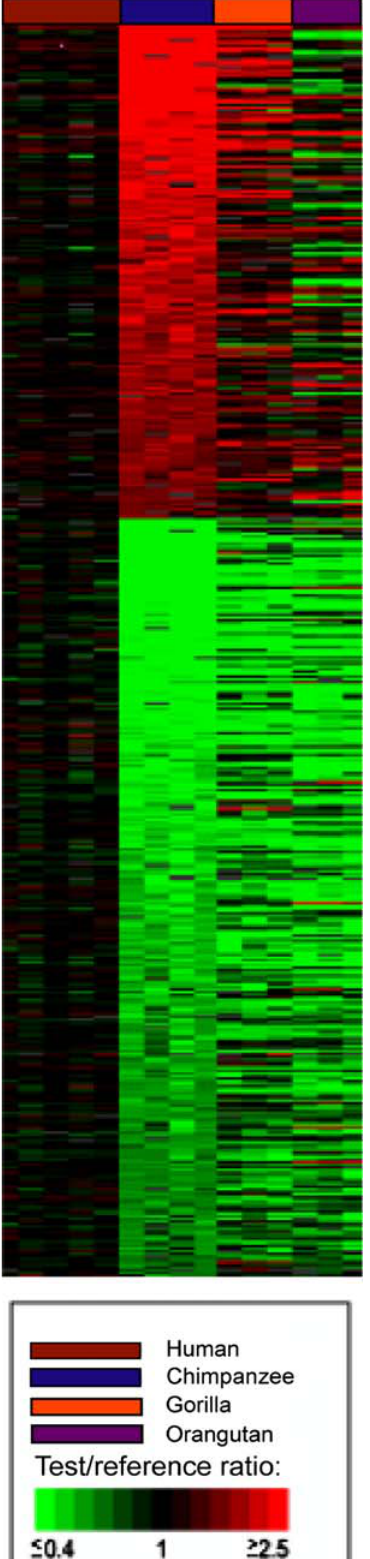
Figure 3. Treeview Image Illustrating the Value of Out-Groups in Identifying Lineage-Specific Copy Number Changes cDNAs shown were selected from a genome-wide dataset [34] to reflect cDNA aCGH–predicted copy number changes between only human and chimp lineages. Also shown are data from gorilla and orangutan for the same cDNAs. Human DNA (labeled green) was used as the reference for all comparisons, while the test samples (labeled red) were human (5), chimp (4), gorilla (3), and orangutan (3). Data illustrate how detection of a copy number difference between human and chimp may not be a reliable predictor that such a change is either human or chimp lineage-